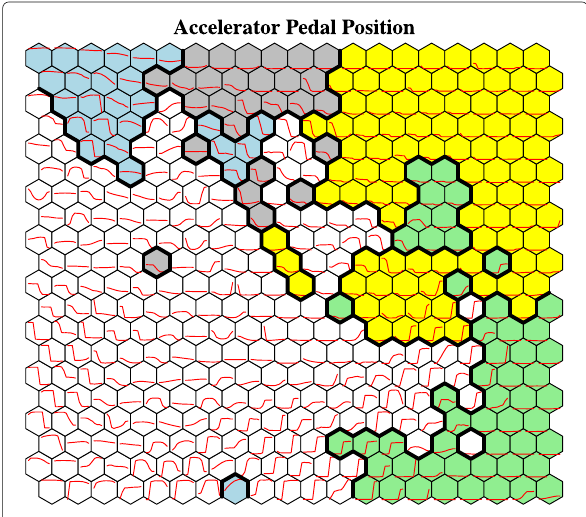
Fig. 7 Accelerator Pedal Position Map. 10-second accelerator pedal position curve for each node represented as a line plot within the respective node